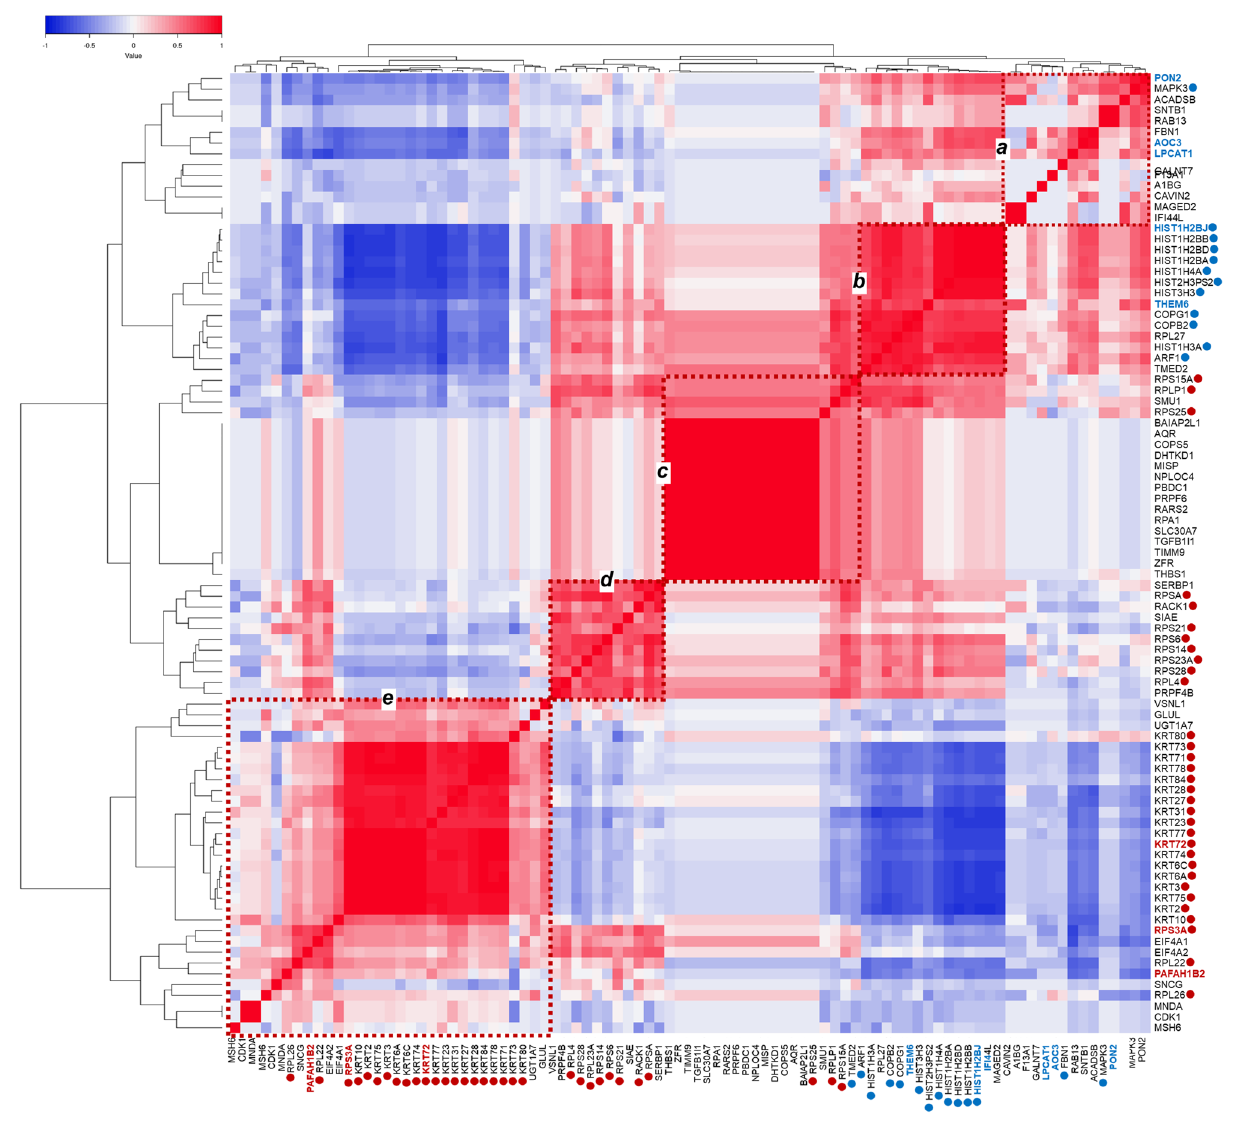
traits. Clusters are denoted by a , b , c , d , and e . Eigen proteins in the WGCNA network modules significant for SqCC or PPA are denoted in red or blue letters, respectively; the hub proteins are also indicated by red or blue- filled circles,